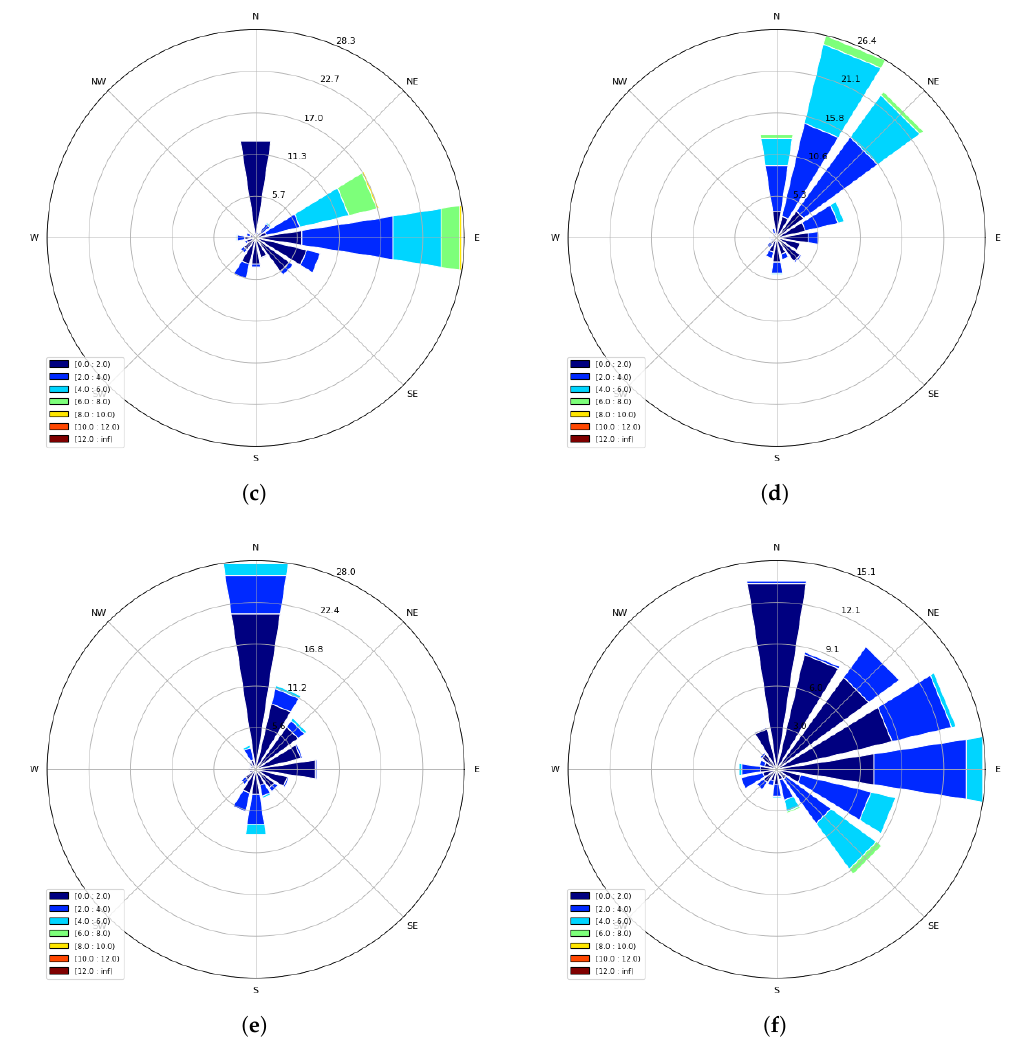
Figure 2. Wind direction and speed frequency at 10 m at each location. ( a ) Faaa. ( b ) Tautira.